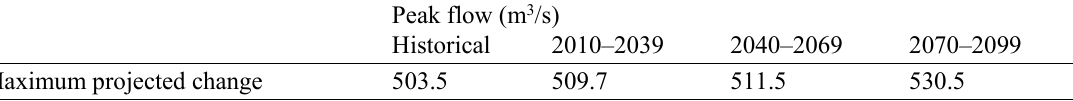
Table 2 Peak flows for historical data and maximal scenarios. Tr = 100 years.